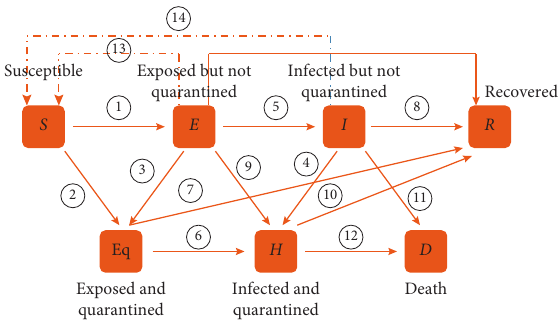
Figure 2: The epidemic transmission